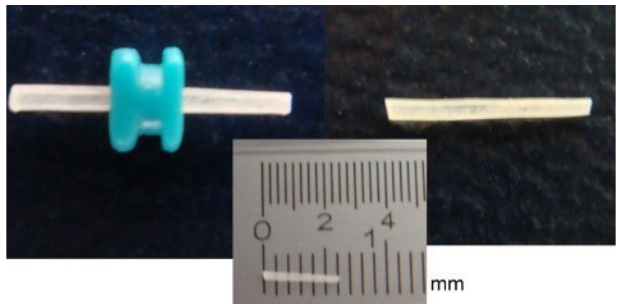
FIGURE 1 - CBV-PLGA implant produced through a hot- molding technique. The implant is compared using a 0.45 mm Trocater and its length with a